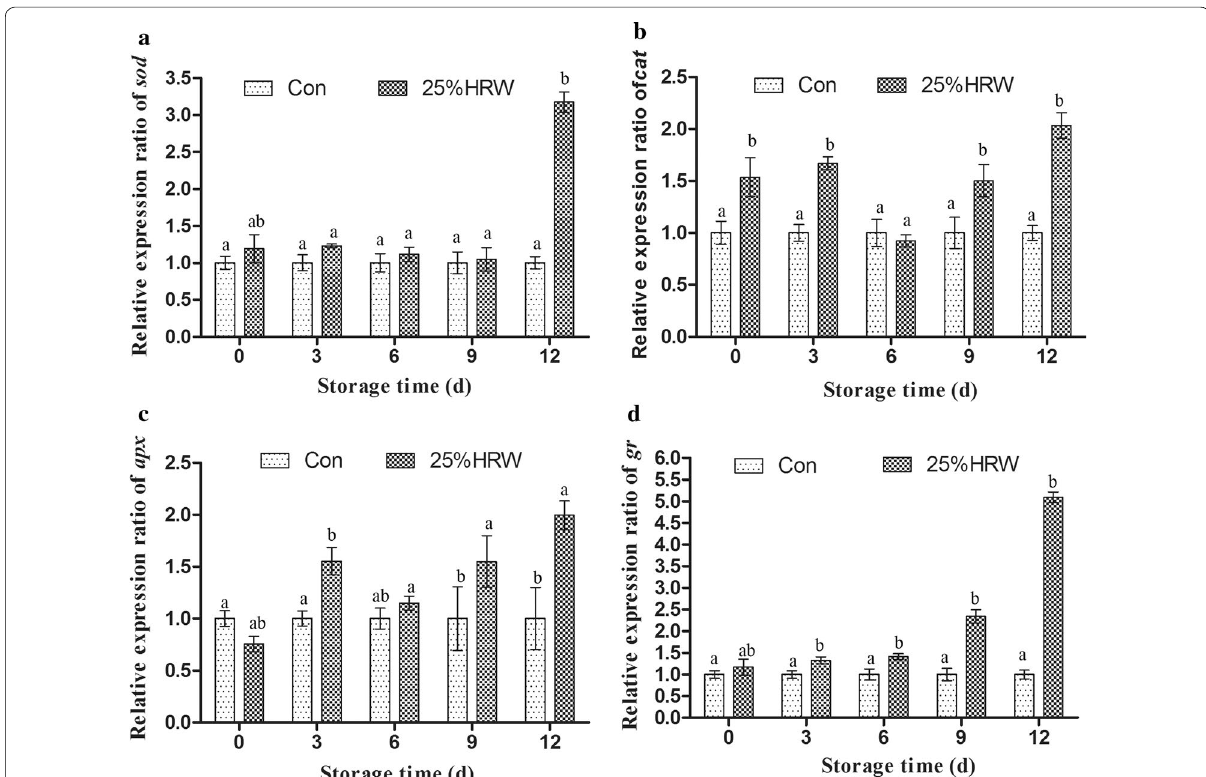
Fig. 6 Effects of HRW on antioxidant enzyme gene expression levels of sod ( a ), cat ( b ), apx ( c ) and gr ( d ) during storage at 4 °C. Con control